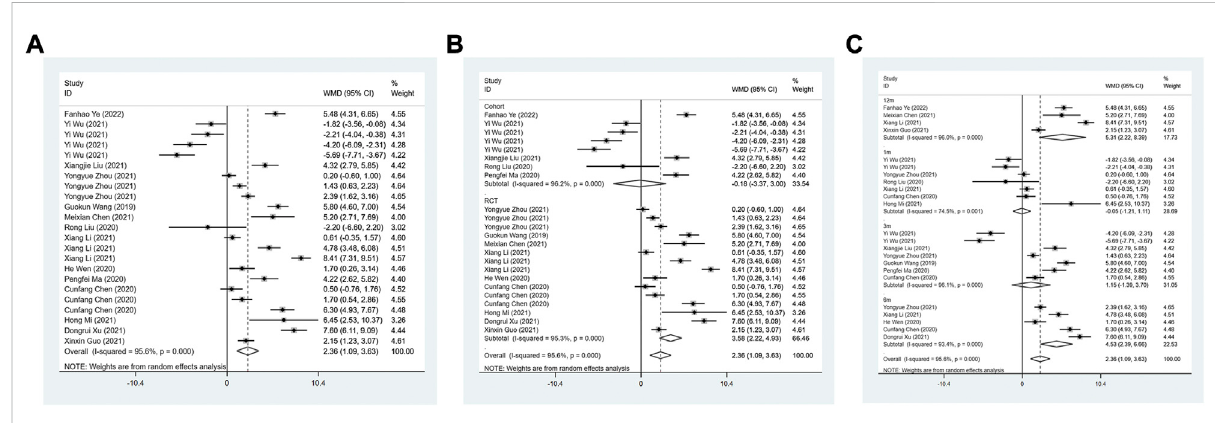
FIGURE 2 Forest plot of LVEF between sacubitril-valsartan and ACEI or ARB; (A) overall; (B) subgroup analysis of study type; (C) duration of treatment.